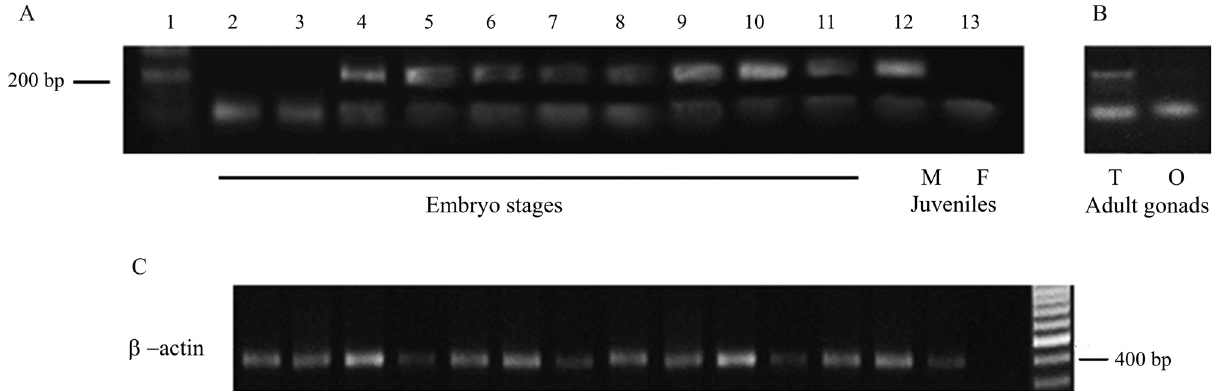
Figure 3 - Amplification products of candidate sex-specific gene expressed in A. charrua . A)1: Mass Ruler DNA ladder (Fermentas); Embryo stages: 2:1-128 cells; 3: early blastula; 4: dispersion phase (annual fish late blastula); 5: reaggregation (annual fish gastrula); 6: 0 to 10 somites; 7: 10 to 20 so- mites; 8: 20 to 30 somites; 9: 3 weeks post fertilization; 10: 1 month post fertilization; 11: pre-hatching embryo; 12: M: male juvenile; 13: F: female